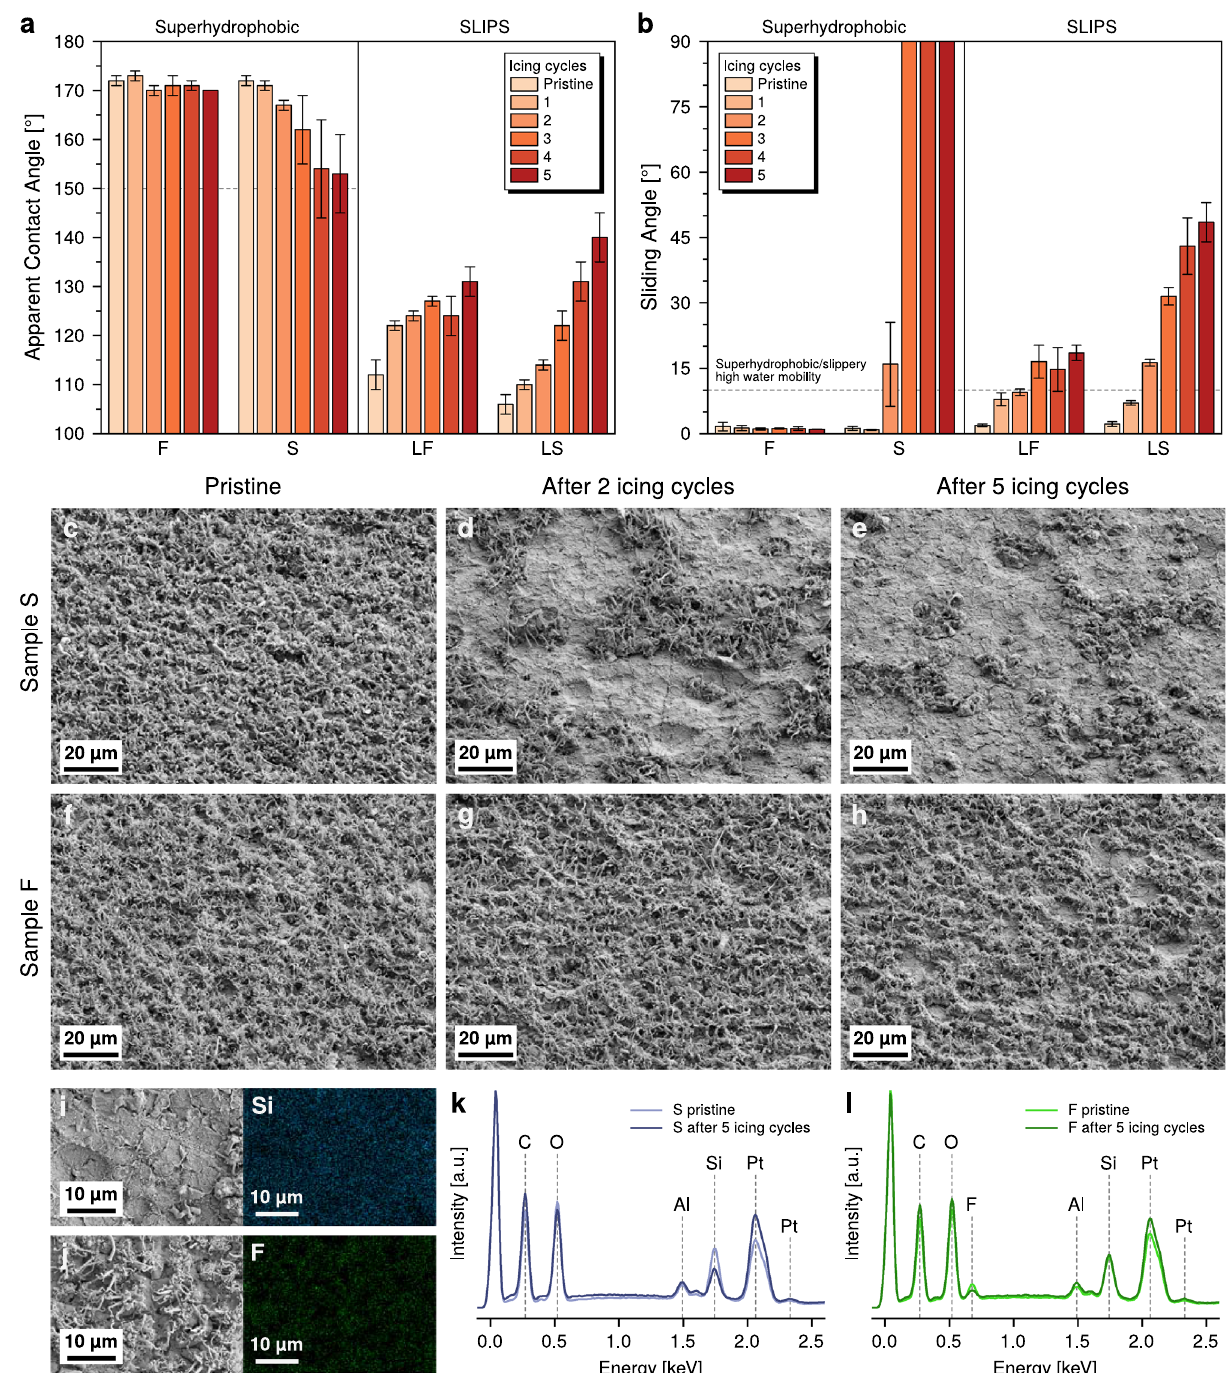
Figure 3. Durability of surfaces against ice adhesion. ( a ) Apparent water contact angle and ( b ) water sliding angle measured on samples before adhesion testing and after each icing cycle. The dashed line in ( a ) represents the lower contact angle threshold for superhydrophobic behavior. ( c – h) Low magnification SEM micrographs showing the evolution of the SNFs coating on ( c – e) sample S and ( f – h ) sample F with increasing number of icing cycles. ( i ) SEM micrograph of sample S after 5 icing cycles (left) and its EDX Si map (right). ( j ) SEM micrograph of sample F after 5 icing cycles (left) and its EDX F map (right). ( k , l ) EDX spectra of ( k ) sample S and ( l ) sample F before and after ice adhesion